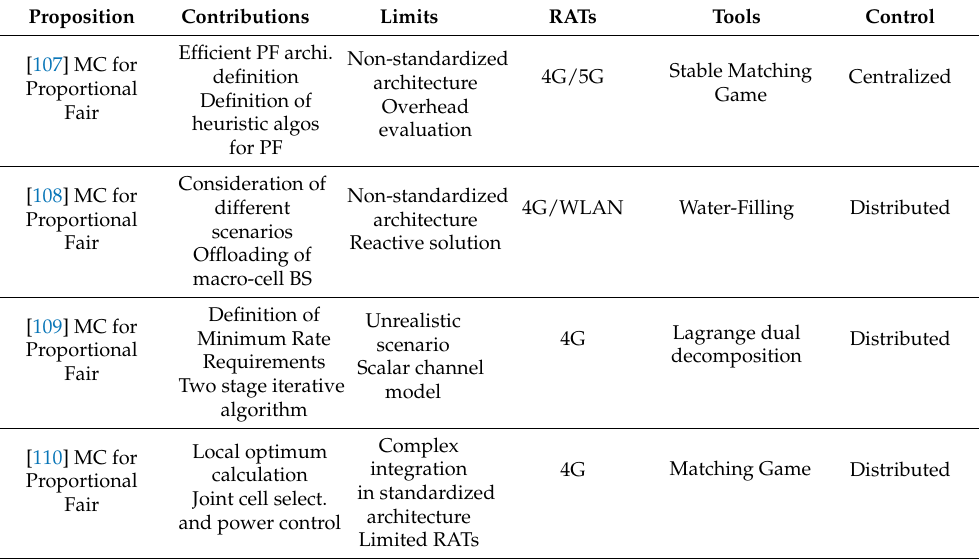
Table 5. Comparison of existing solutions for improving